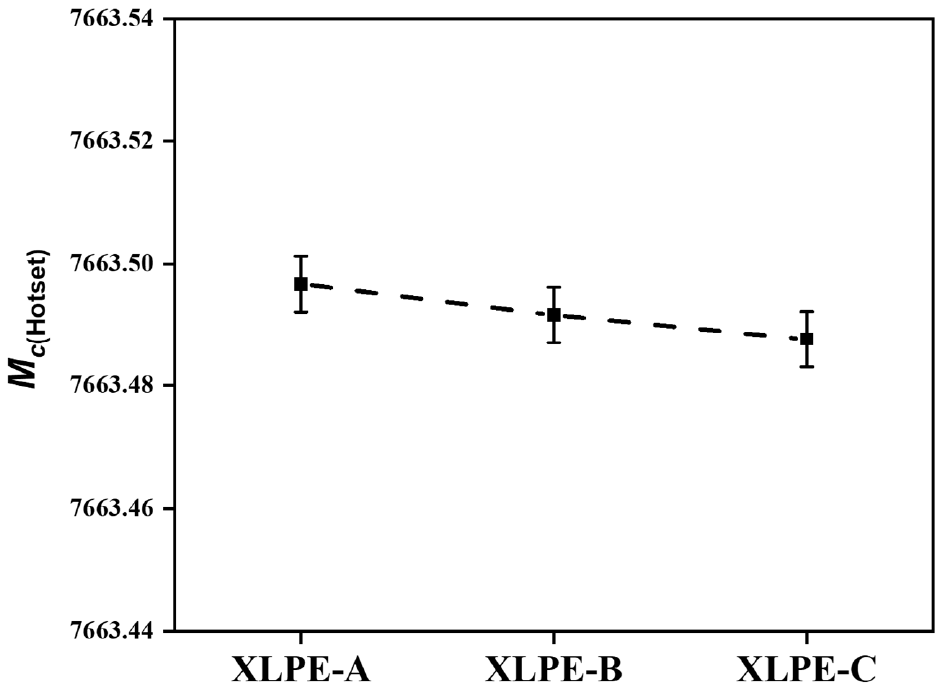
Figure 4. Average molecular weight among two crosslinks for XLPE prepared with DCP content of 1.4% (XLPE-A), 1.7% (XLPE-B) and 2% (XLPE-C).